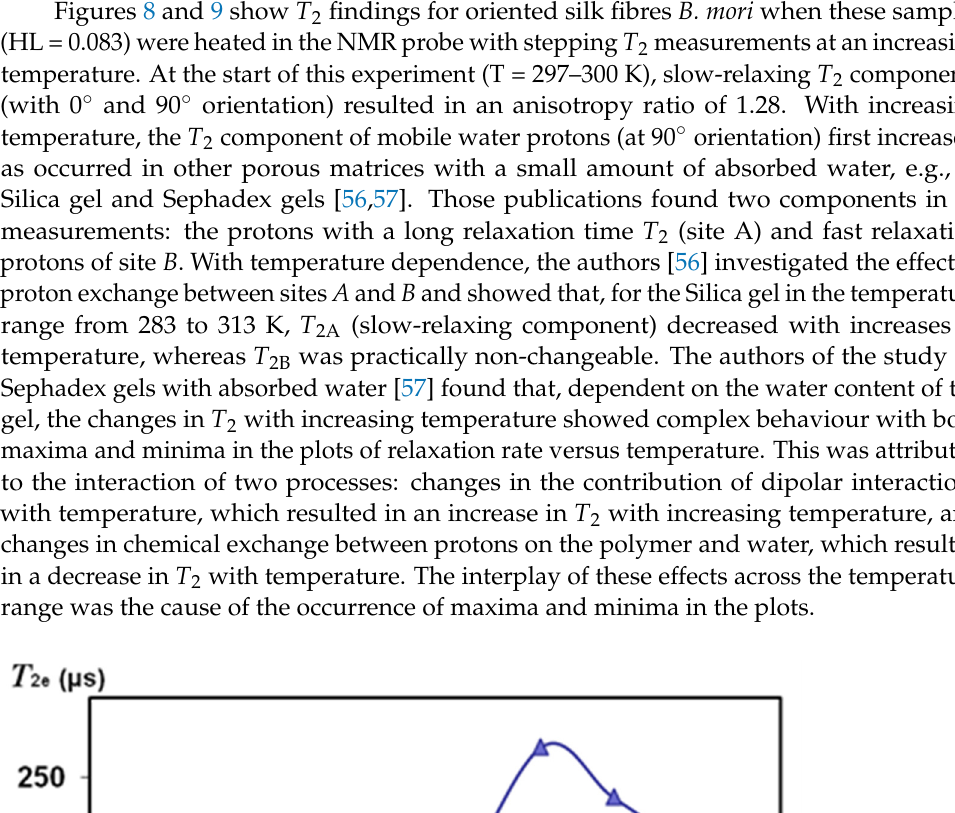
Figure 9. Temperature dependence of the apparent fast-relaxing T 2 component in two silk fibres B.mori samples (originally HL = 0.083); the samples were slowly heated in the NMR coil being meas- ured after each 5–7° step. Dash lines provide guidance for the eye. 1) (Blue triangles) silk fibres with 90° orientation; 2) (Black circles) silk fibres with 0° orientation.